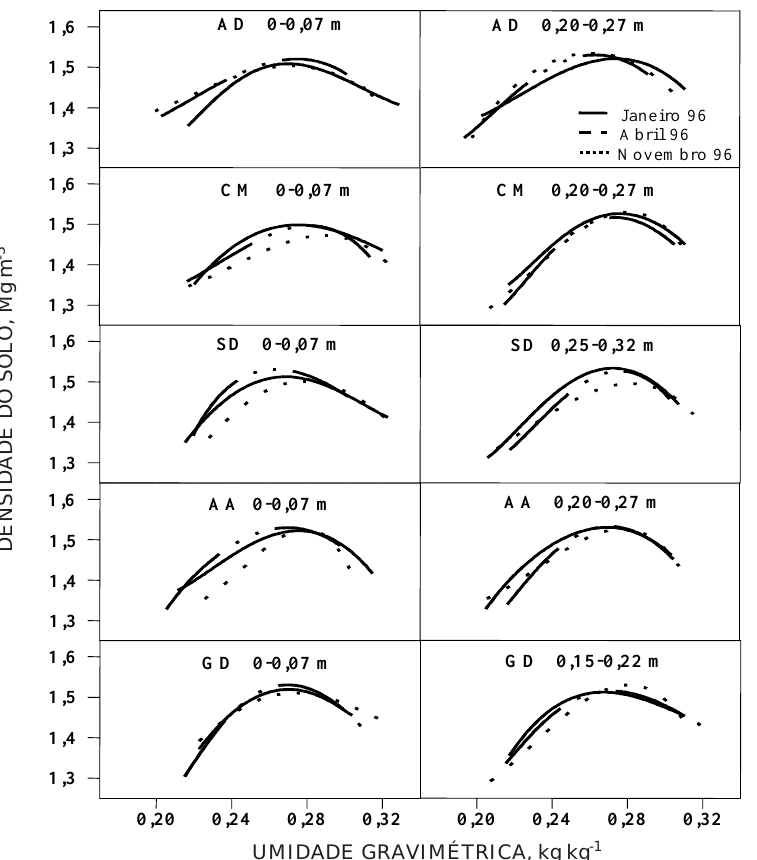
Figura 1. Curvas de compactação de um Latossolo Roxo, considerando o sistema de manejo, a